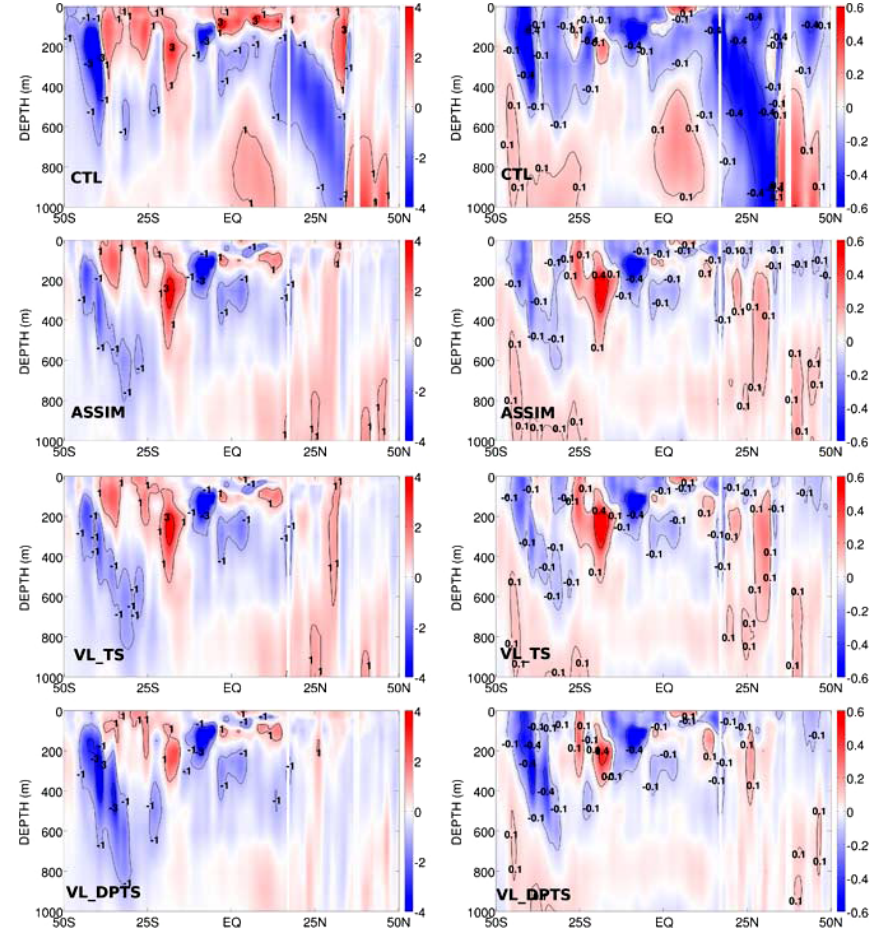
Figure 5. The model mean minus WOA13 along 25 ◦ W in the upper 1000m for temperature ( ◦ C) on the left and salinity (psu) on the right from 1 January 2010 to 31 December 2012 according to the CTL run and the prior state of the ASSIM, VL_TS and VL_DPTS